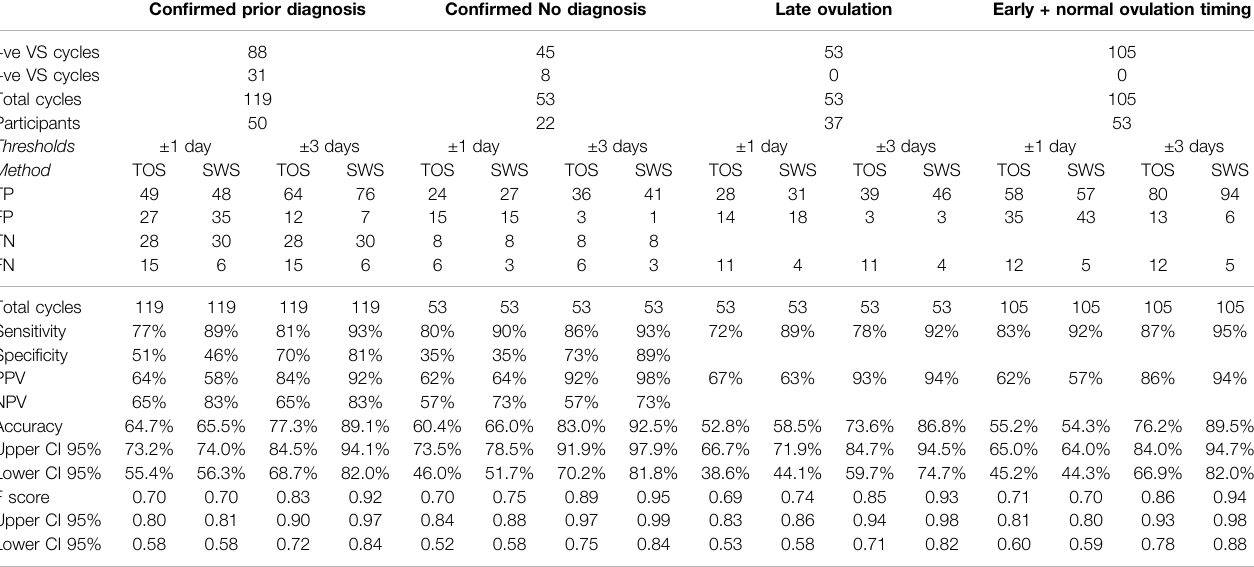
TABLE 11 | Threshold method results for TOS and SWS compared with VS for diagnosis and ovulation timing groups. Con fi rmed prior